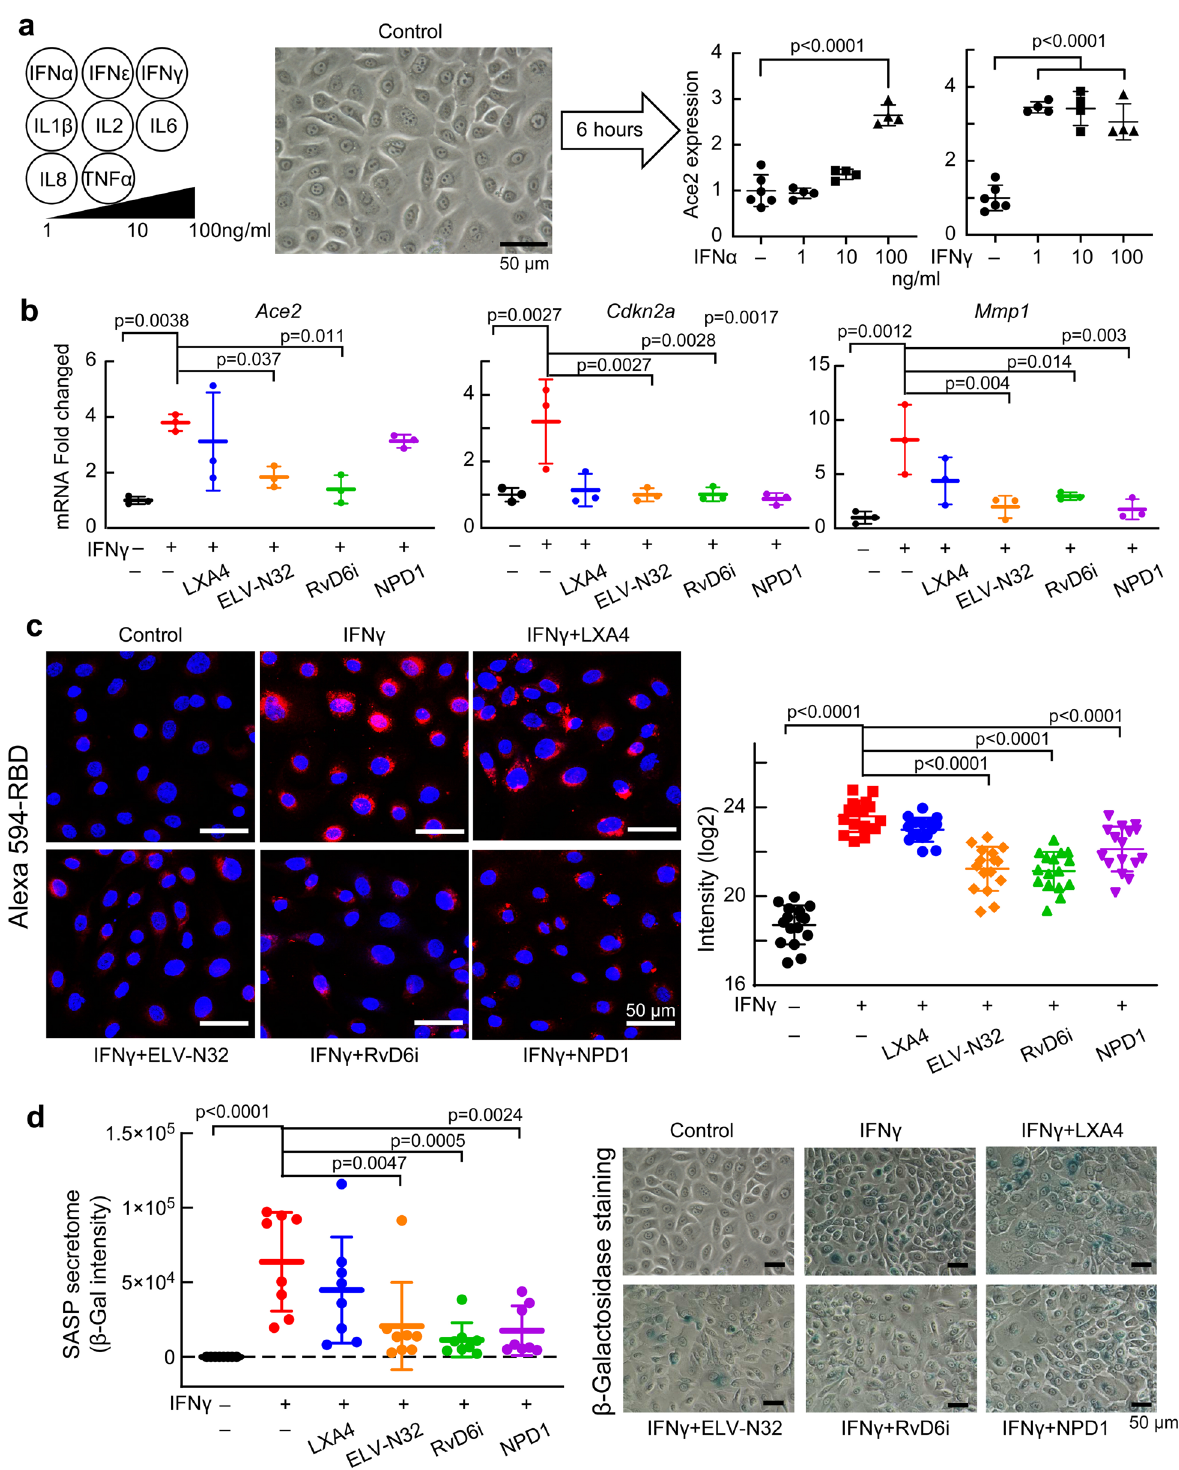
Figure 4. Lipid mediators attenuate IFNγ-induced ACE2 expression, senescence programming, and binding of Alexa 594-RBD in human corneal epithelial cells (HCEC). ( a ) Among several cytokines tested only IFNγ and α, induces ACE2 expression in HCEC (6 h after stimulation, analyzed by dd-PCR). ( b ) Effect of lipid mediators on gene expression of Ace2 , Cdkn2a , and Mmp1 of HCEC after adding IFNγ (100 ng/mL). ΔΔC T normalized fold change was used. p-values of statistical t test analysis in comparison to vehicle group are shown. Mean and SD are shown as the lines. ( c ) Alexa 594-RBD binding in HCEC. IFNγ (100 ng/mL) and lipid mediators (200 nM) were added to the HCEC for 12 h. Alexa 594-RBD (0.5 ng/well) was then added and images taken 24 h after. Fifteen images/ condition analyzed. Representative images are shown (left side), and the Imaris based calculation was plotted (right-hand side). Data are presented as single image/each data point. The p-value of ANOVA-post hoc Dunnett’s multiple comparisons test with vehicle as reference. Mean and SD are shown as the lines. ( d ) SASP Secretome (β-Gal staining) of HCEC 24 h after IFN-γ challenge and ± lipid mediators. Each point represents one image. The p-value of ANOVA-post hoc Dunnett’s multiple comparisons test with vehicle as reference are shown. Mean and SD are shown as the lines. Representative images for each condition are in the right